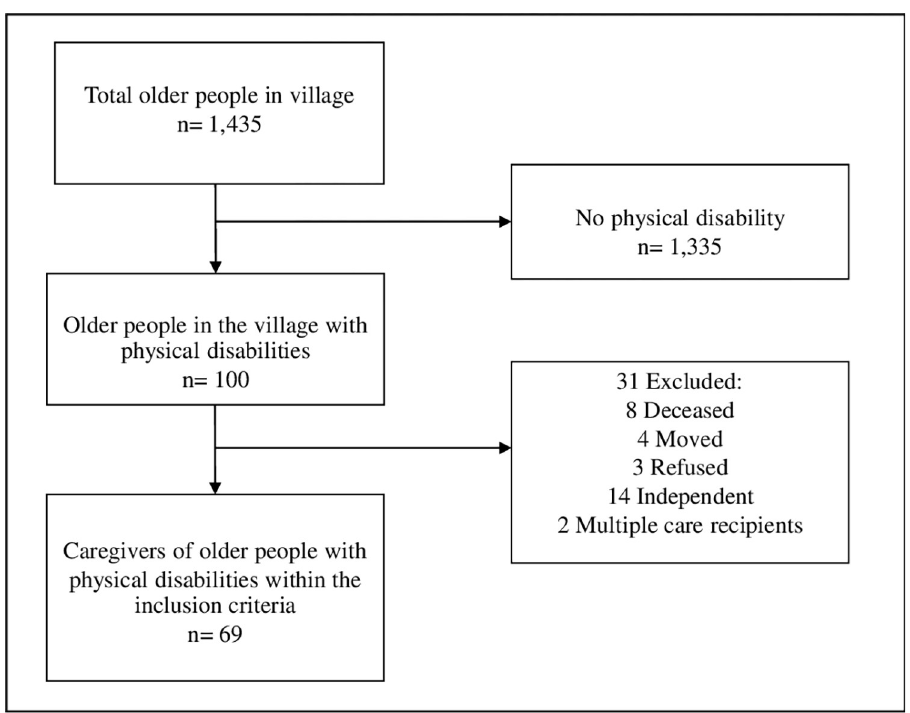
Fig 1. Diagram of the participant selection